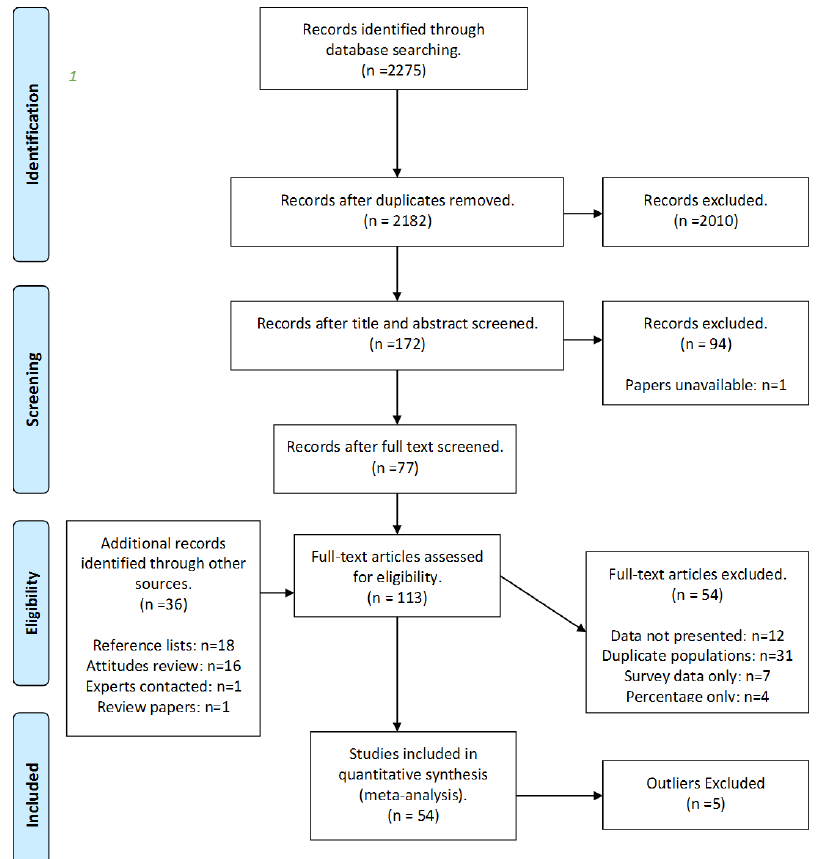
Figure 1. A PRISMA flow diagram of the search process (a separate review of public attitudes towards farm animal welfare was conducted simultaneously to this, and relevant references identified through this search process were included in this review. The review paper in question was [39]).